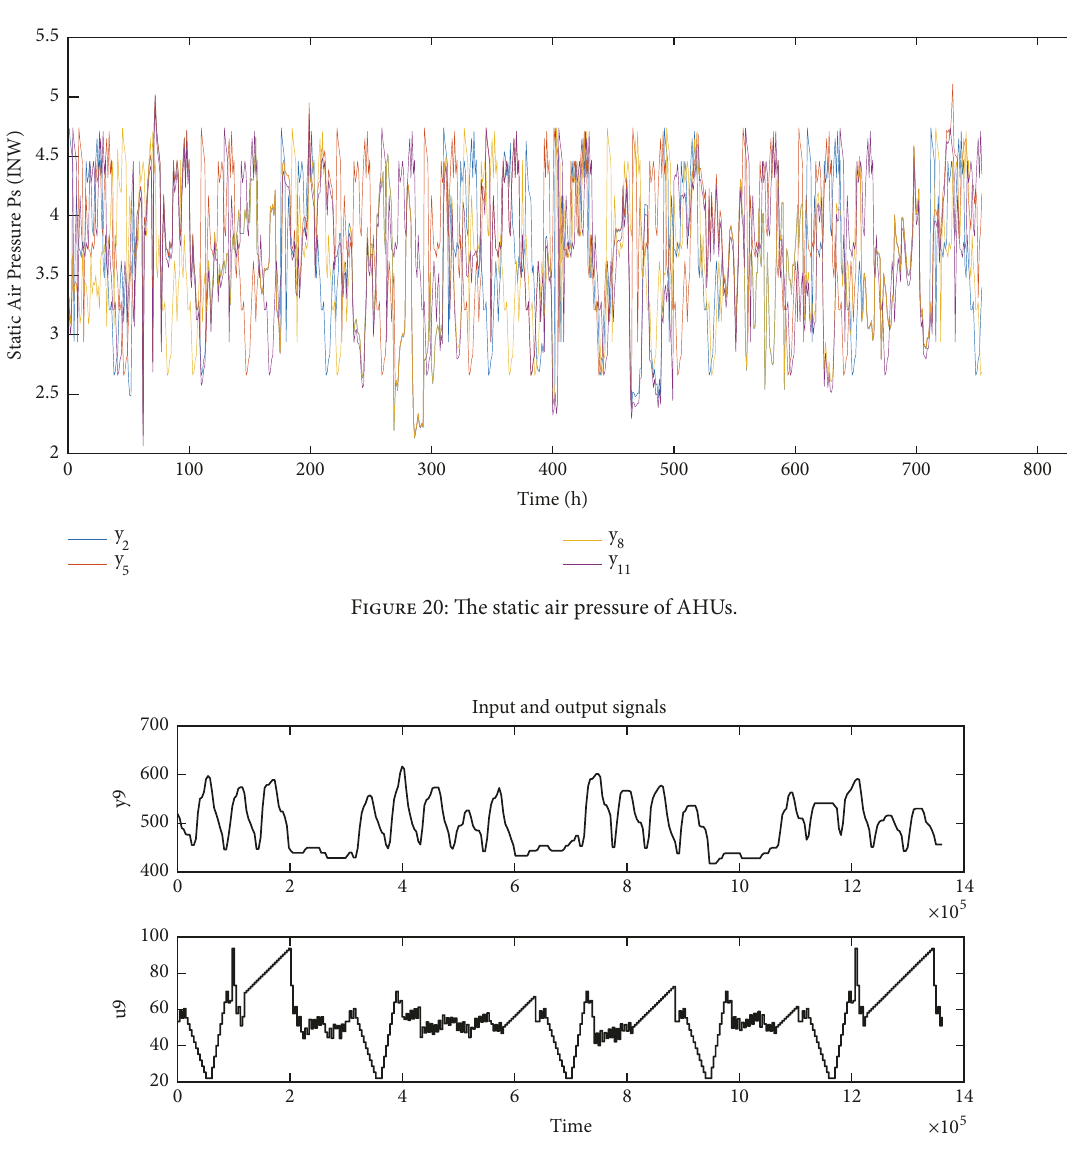
Figure 21: Input and output signals of CO 2 level of AHU 3